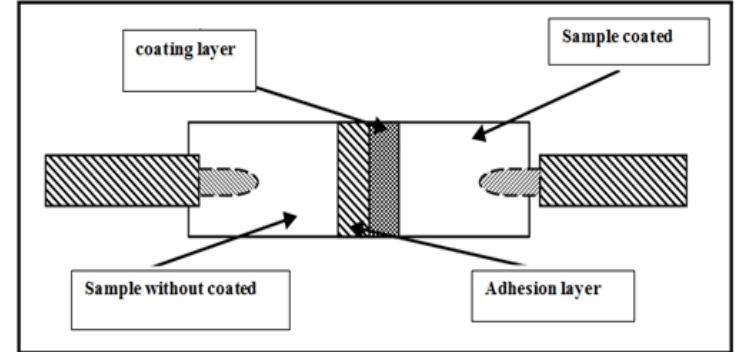
Fig.3: Schematic for samples fixed on the adhesion machine